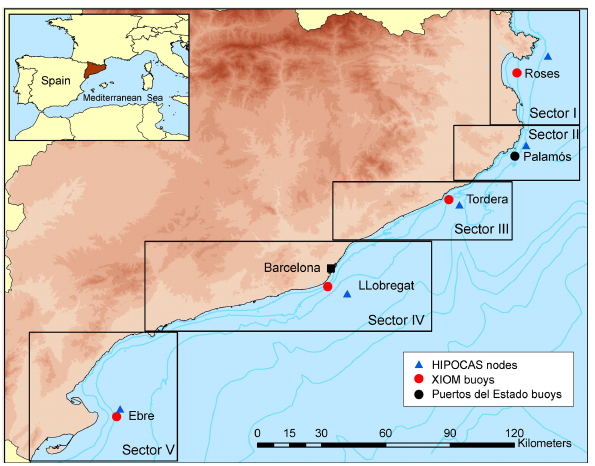
Fig. 1. Study area showing coastal sectors and location of wave buoys and HIPOCAS nodes.